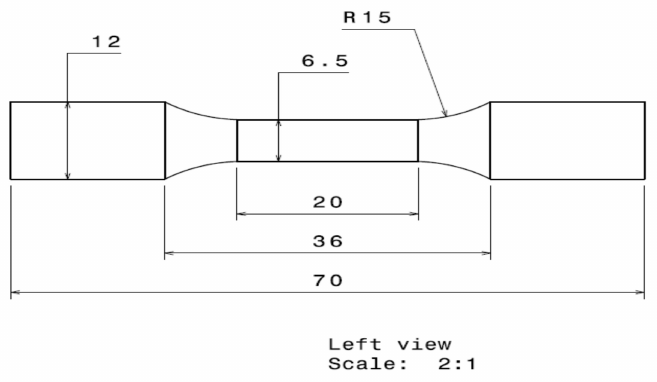
Figure 3. Dimensions of the sample prepared for the tensile